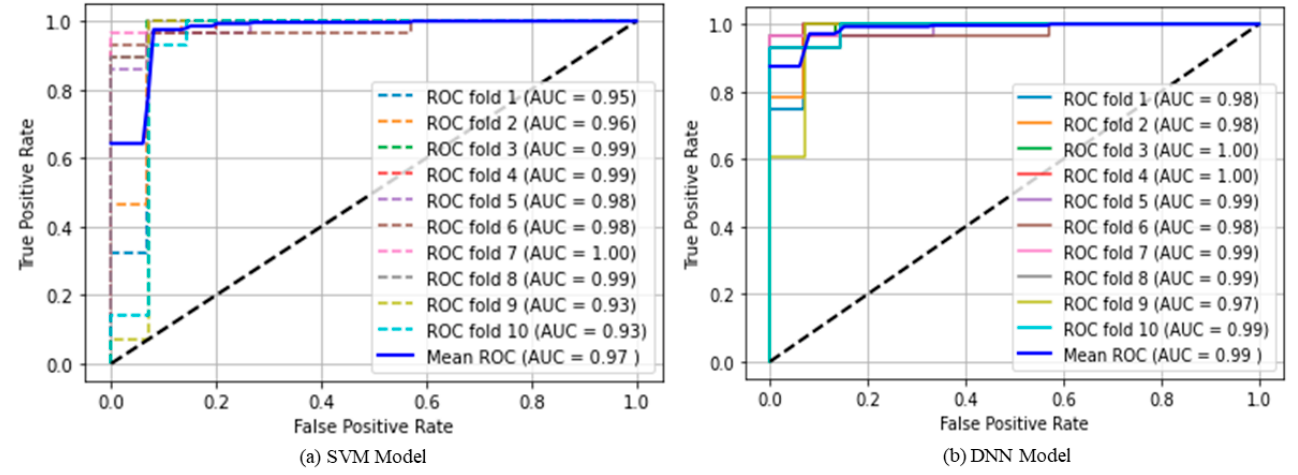
ROC plots, mean ROC plot, AUC scores, and mean AUC score of both the models.